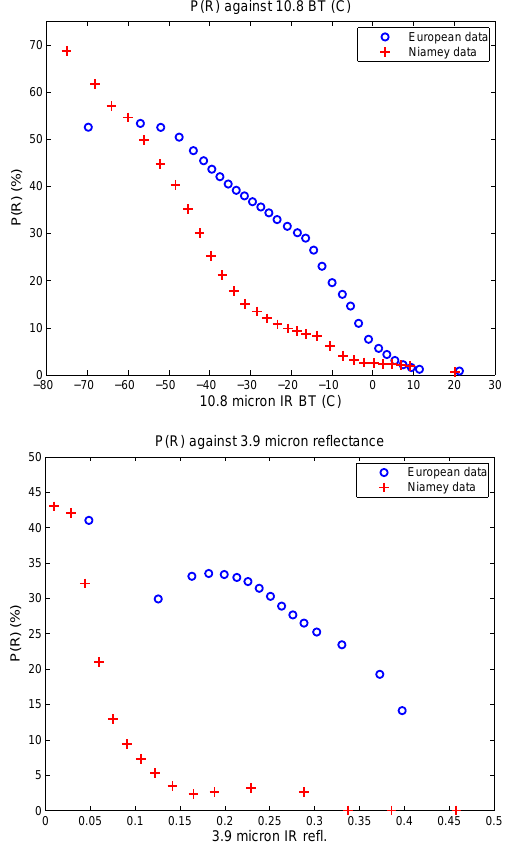
Fig. 1. Probability of rainfall (P(R)) for radar against nearest SE- VIRI pixel for 10.8µm BT (top) and 3.9µm refl. (bottom) from Eu- ropean and Niamey data are shown. Each data point corresponds to one radiance bin in the SatPrecip and TAMORA algorithms respec- tively. For the 3.9µm channel, only data where the corresponding 10.8µm BT is ≤ − 20 ◦ C are used in order to eliminate clear sky ra- diances. European data are for all months combined, Niamey data are for JAS